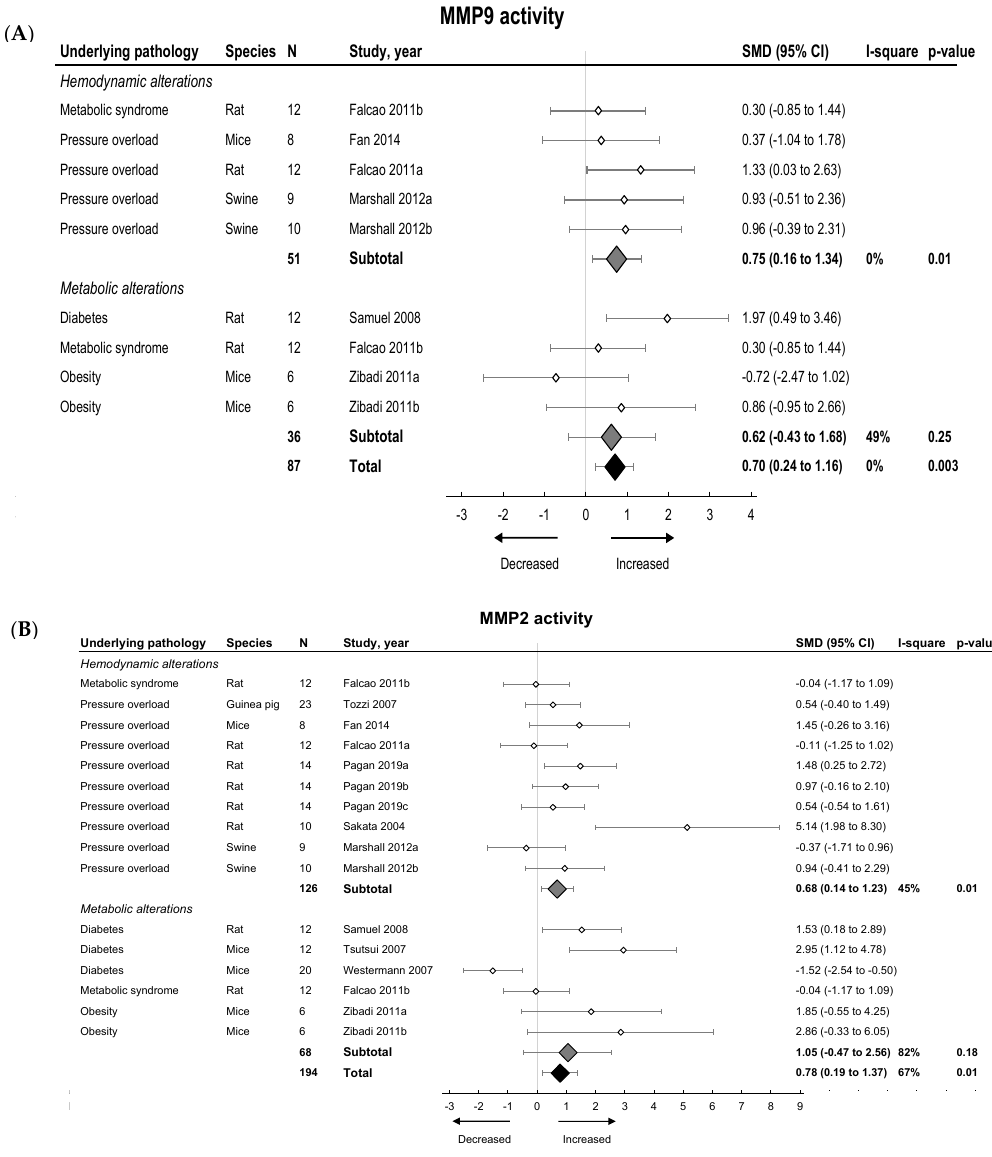
Figure 6. The effect of LVDD/HFpEF on MMP2 (panel ( A )) and MMP9 (panel ( B )) activity. Forrest plot; the right side shows an increased effect in LVDD/HFpEF animals, the left side shows a decreased effect in LVDD/HFpEF animals. Data are presented as SMDs with 95% CI. Arrows indicate increased and decreased MMP2 ( A ), and increased and decreased MMP9 ( B ) enzyme activity respectively. Only the first author of each study is shown; multiple comparisons within one study are shown with a, b, c or d and correspond with the study overview (Table S1). CI, confidence interval; I 2 , measurement of heterogeneity; MMP, matrix metalloproteinase; N, cumulative sample size; SMD, standardized mean difference; TIMP, tissue inhibitor of metalloproteinase.